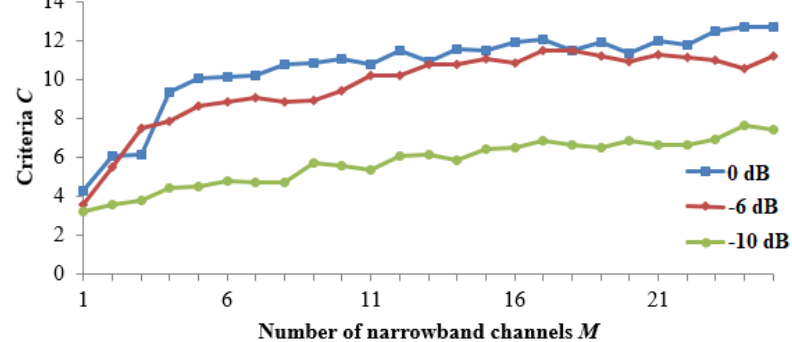
Fig. 2. The dependency C ( M ) for the algorithm based on quadratic